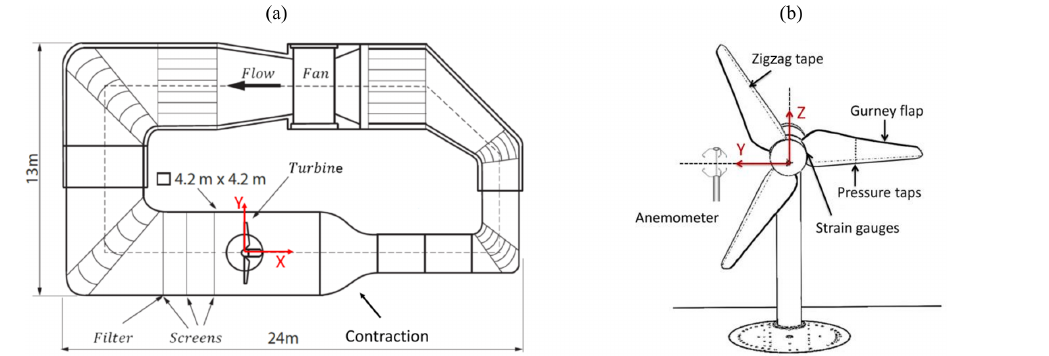
Figure 3. (a) Closed-loop wind tunnel in top view, reproduced and modified from Klein at al. (2018). (b) BeRT setup in front view looking